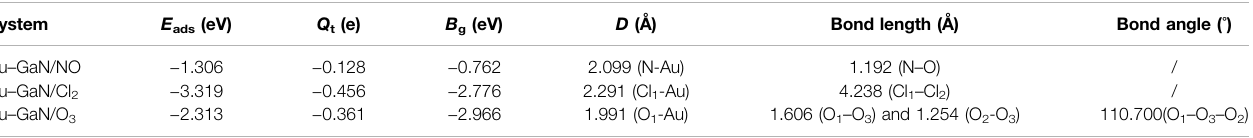
TABLE 3 | Adsorption parameters of NO, Cl 2 , and O 3 on the Au – GaN surface.